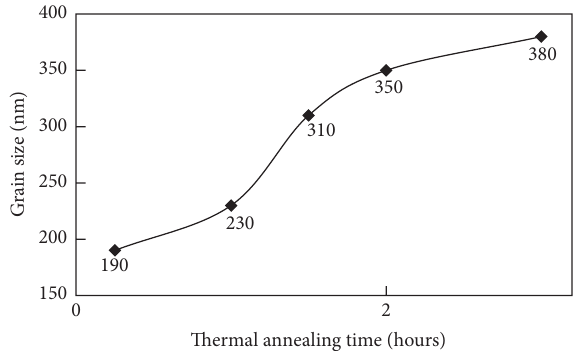
Figure 6: Plot of highest percentage of grain size present in each film with increasing thermal annealing